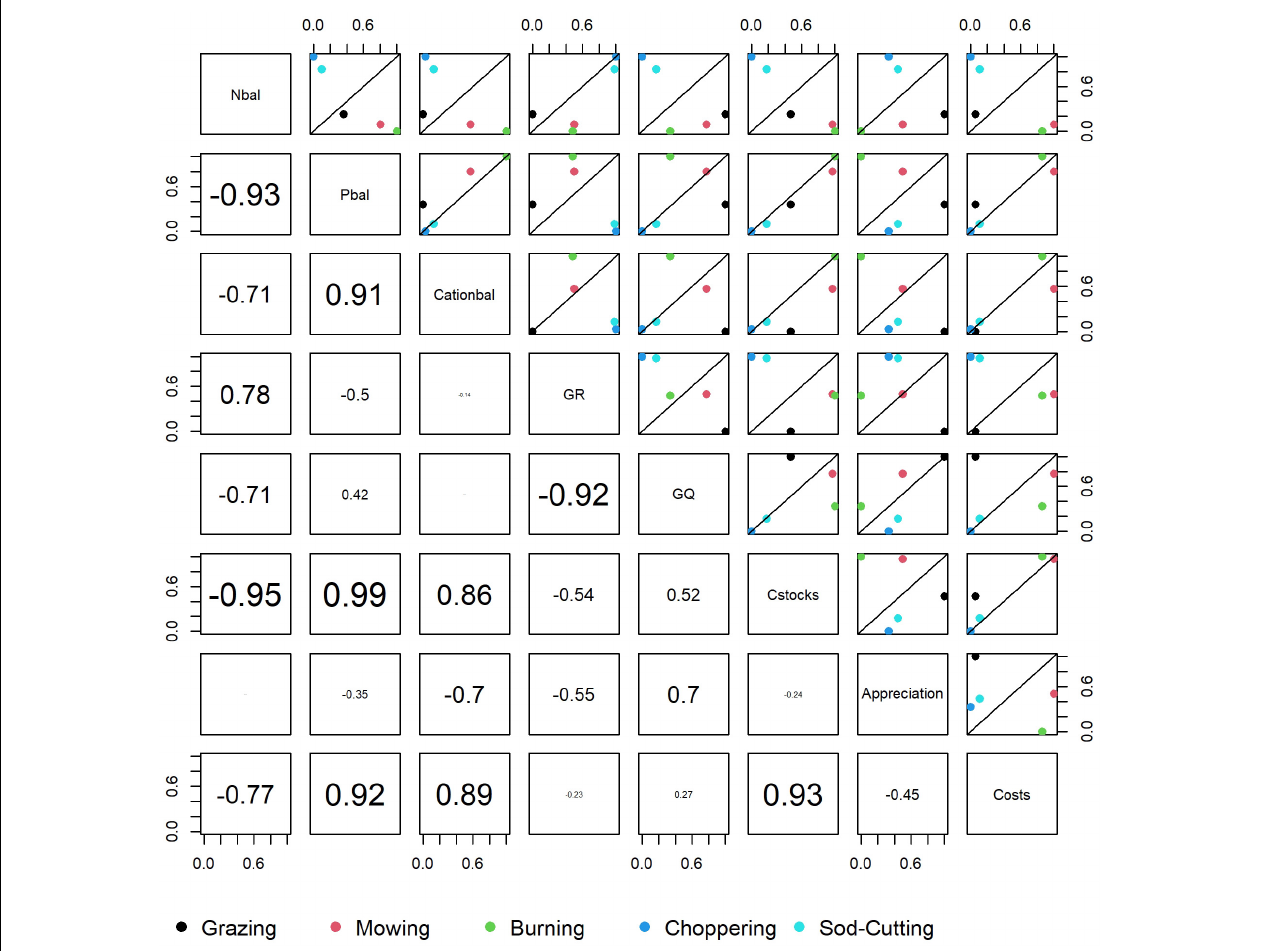
FIGURE 3 | Pairwise comparisons between TC std . The upper panel shows the relative benefits ( TC std ) between all possible pairwise trade-off component comparisons. The 1:1 line represents the situation where there is no trade-off between the two TC std being compared, whilst a move away from this line represents a trade-off. The diagonal from top left to bottom right (slope of − 1, intercept zero) represents the line of average benefit (not shown). All values below this line represent a situation where the management practice provides less benefit with regard to the two TC compared, whilst any management practice above this line provides more benefit. In the lower panel, the Pearson correlation coefficients are shown scaled according to their absolute value. Abbreviations as in Table 2